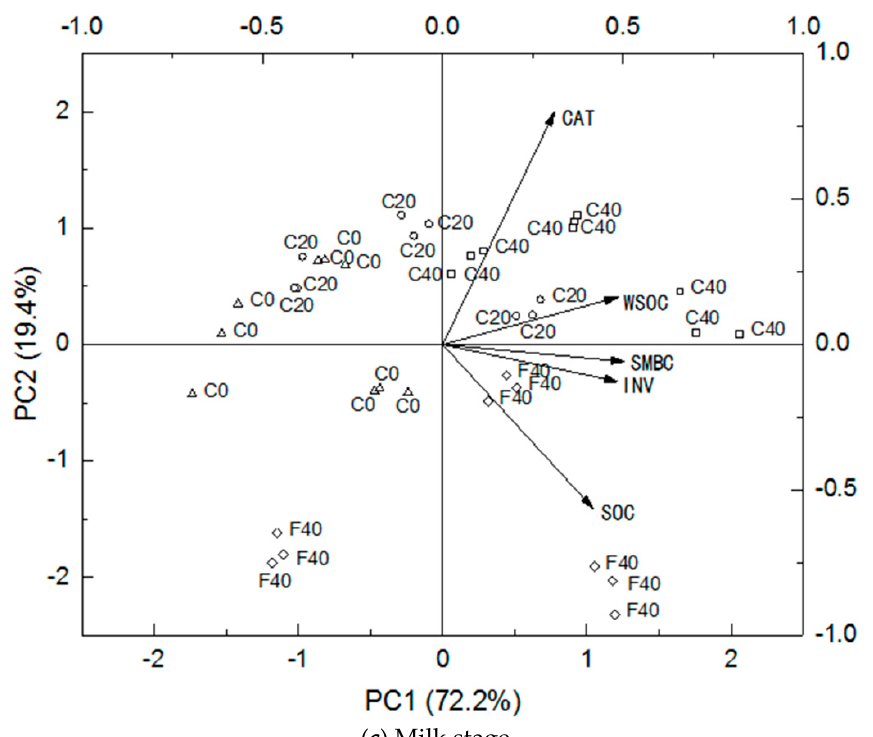
Figure 1. Principal component analysis (PCA) of the relationships of the fractions of SOC and its components with soil enzyme activities at different growth stages of rice. ( a ): PCA biplot at tillering stage; ( b ): PCA biplot at jointing and booting stage; ( c ): PCA biplot at milk stage.